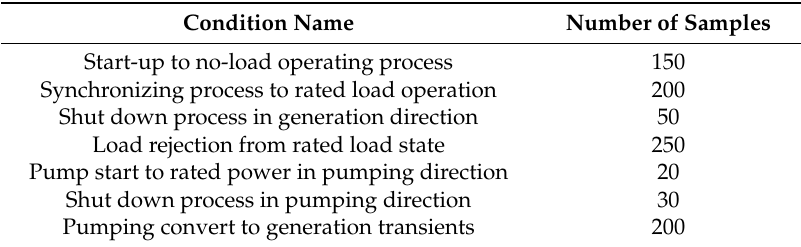
Table 2. Detailed composition of the training samples for T-S